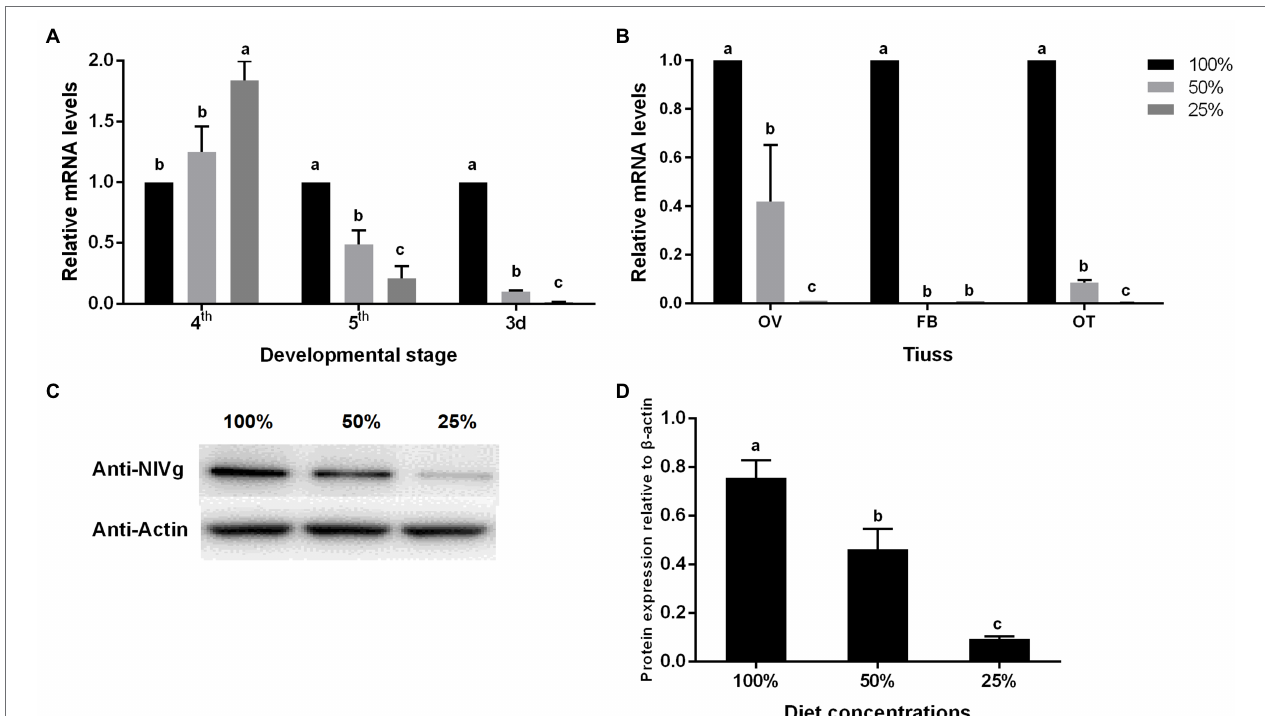
FIGURE 4 | Effect of nutrient concentration on Vg expression of the BPH of (A) different ages, (B) different tissues, and (C,D) Vg protein accumulation of the BPH in adults on day 6. Data are presented as mean ± standard error ( n = 3); different letters represent significant differences ( p < 0.05, Duncan’s multiple range